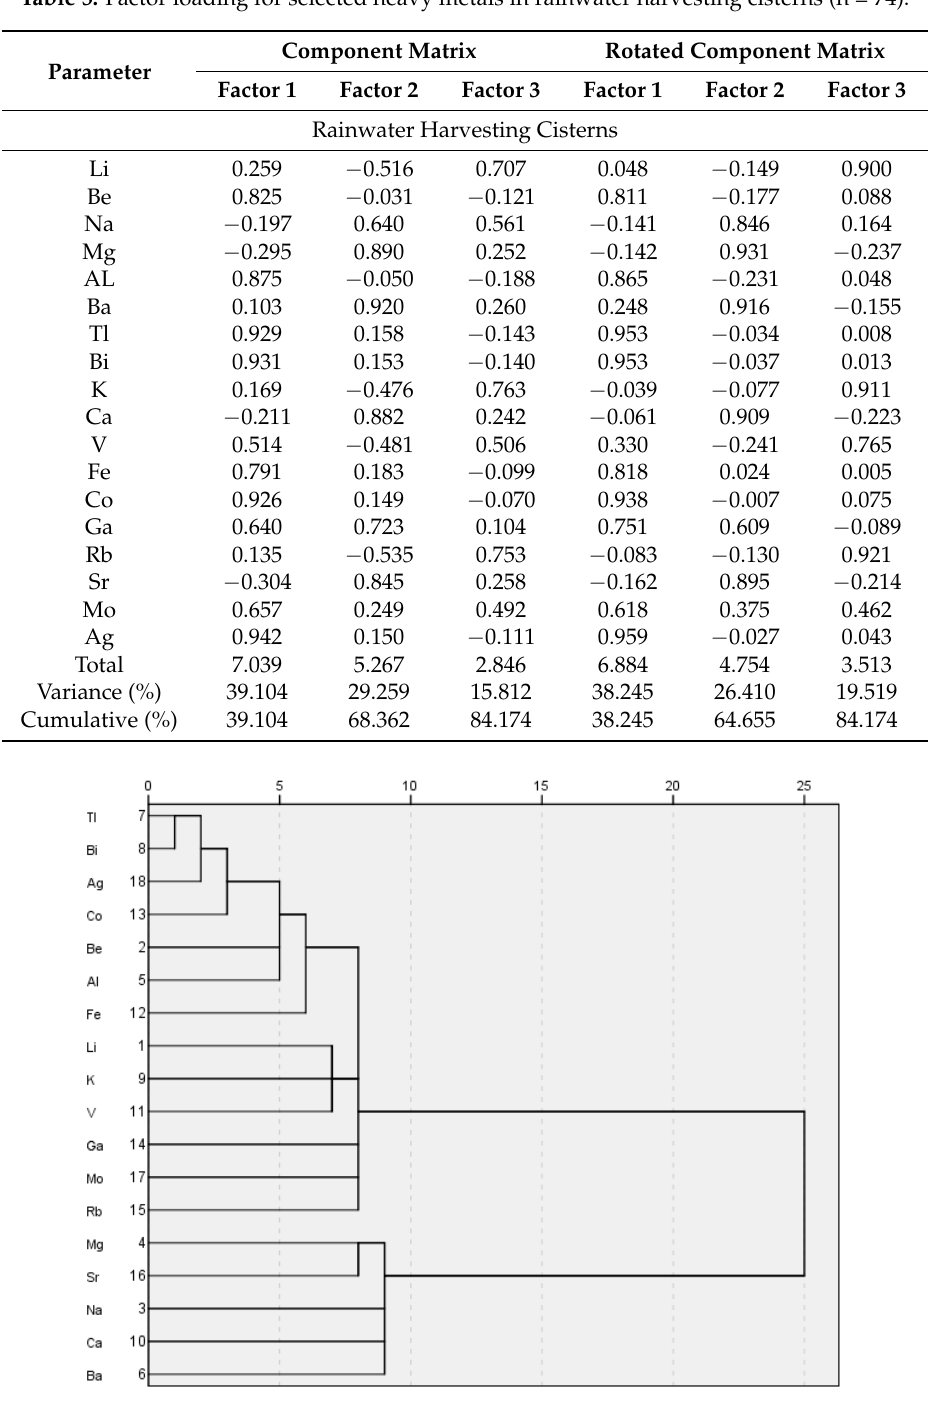
Figure 2. Heavy metals diagram using median linkage of cluster analysis within rainwater harvesting cisterns.